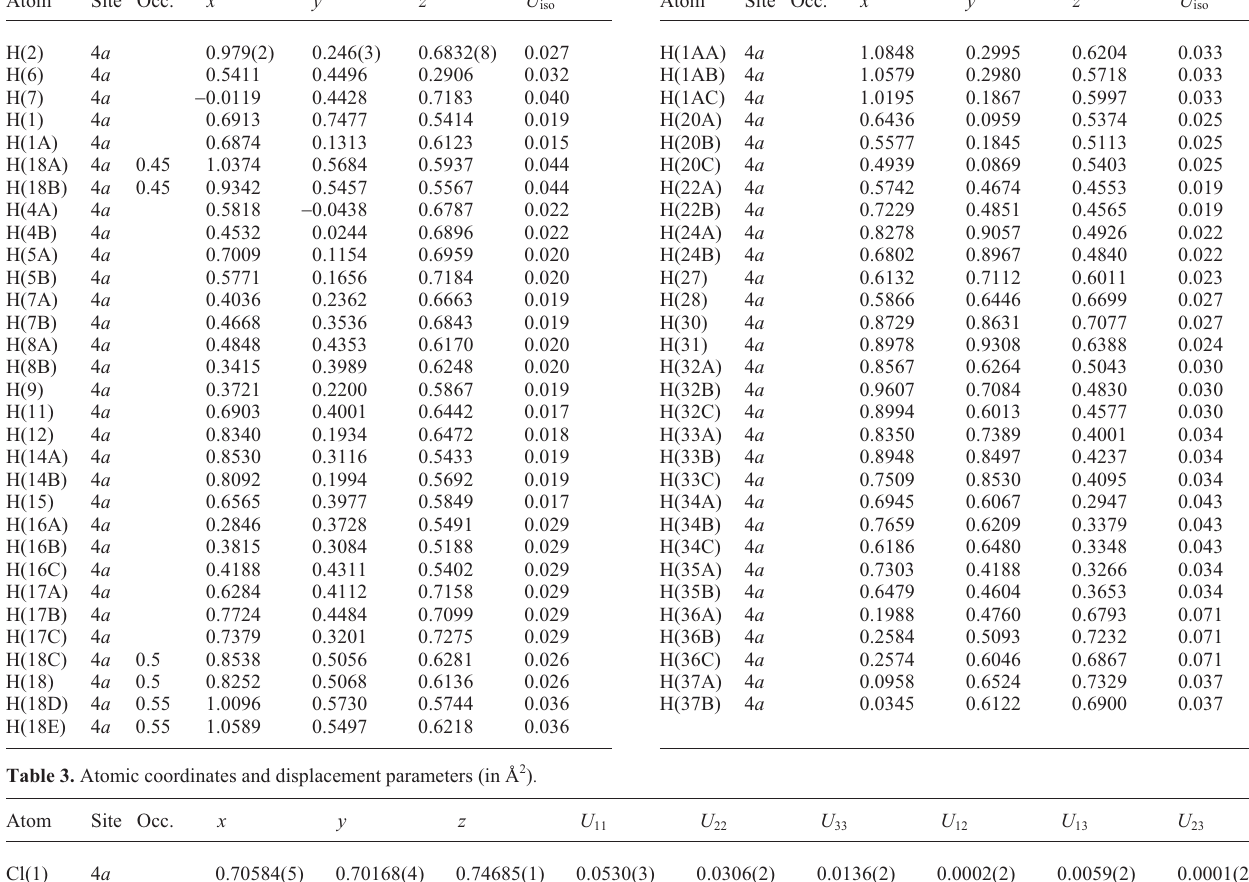
Table 2. Atomic coordinates and displacement parameters (in Å 2 ) . Atom Site